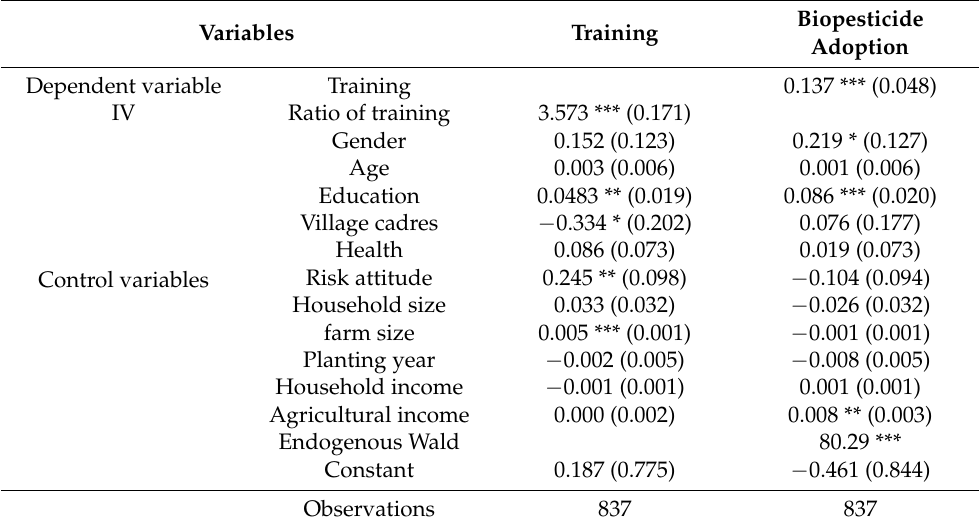
Table 3. Estimates of the IV-probit